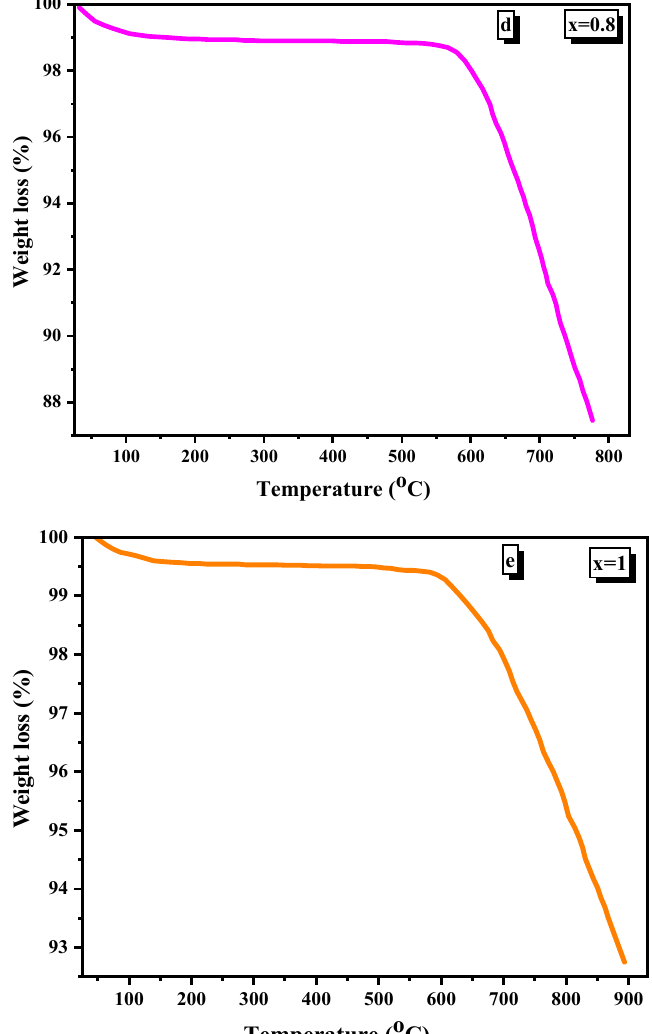
Figure 8. ( a ) TGA curve of Ni (cid:2869)(cid:2879)(cid:2934)(cid:2878)(cid:2870) Mg (cid:2934)(cid:2878)(cid:2870) Fe (cid:2870)(cid:2878)(cid:2871) O (cid:2872) (x = 0). ( b ) TGA curve of Ni (cid:2869)(cid:2879)(cid:2934)(cid:2878)(cid:2870) Mg (cid:2934)(cid:2878)(cid:2870) Fe (cid:2870)(cid:2878)(cid:2871) O (cid:2872) (x = 0.2). ( c ) TGA curve of Ni (cid:2869)(cid:2879)(cid:2934)(cid:2878)(cid:2870) Mg (cid:2934)(cid:2878)(cid:2870) Fe (cid:2870)(cid:2878)(cid:2871) O (cid:2872) (x = 0.6). ( d ) TGA curve of Ni (cid:2869)(cid:2879)(cid:2934)(cid:2878)(cid:2870) Mg (cid:2934)(cid:2878)(cid:2870) Fe (cid:2870)(cid:2878)(cid:2871) O (cid:2872) (x = 0.8). ( e ) TGA curve of Ni (cid:2869)(cid:2879)(cid:2934)(cid:2878)(cid:2870) Mg (cid:2934)(cid:2878)(cid:2870) Fe (cid:2870)(cid:2878)(cid:2871) O (cid:2872) (x = 1).